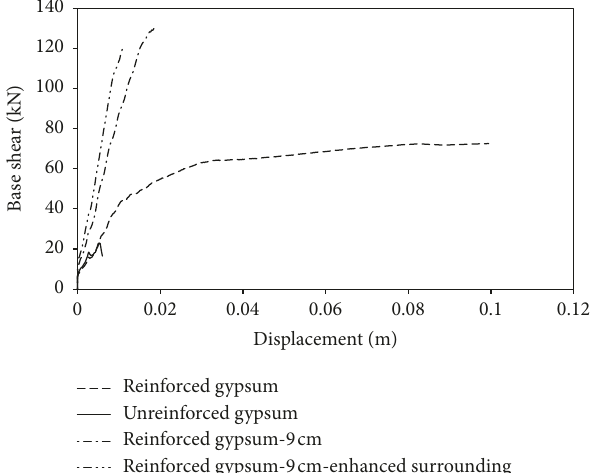
Figure 9: Comparison of the force-displacement curves of the